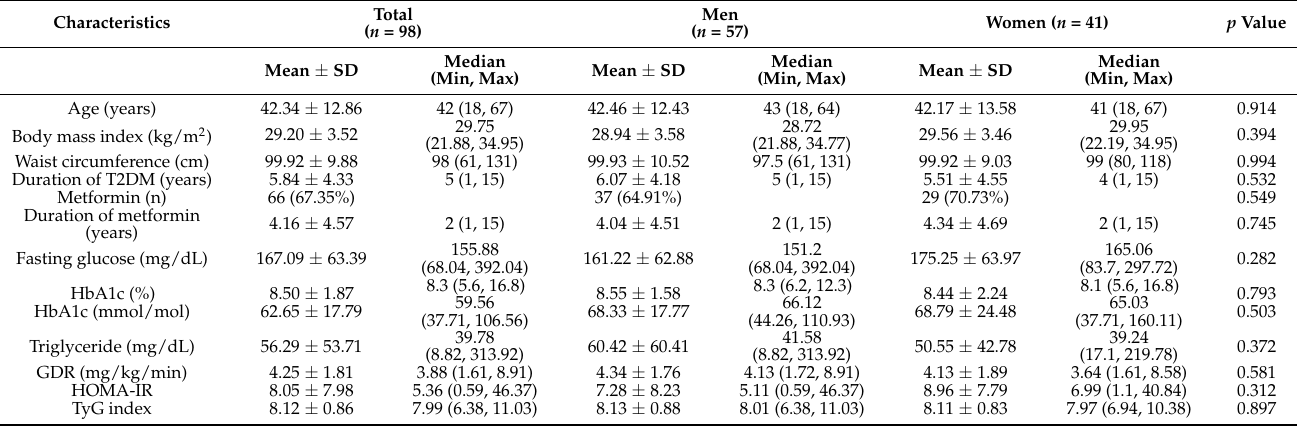
Table 1. Clinical characteristics of patients ( n = 98).